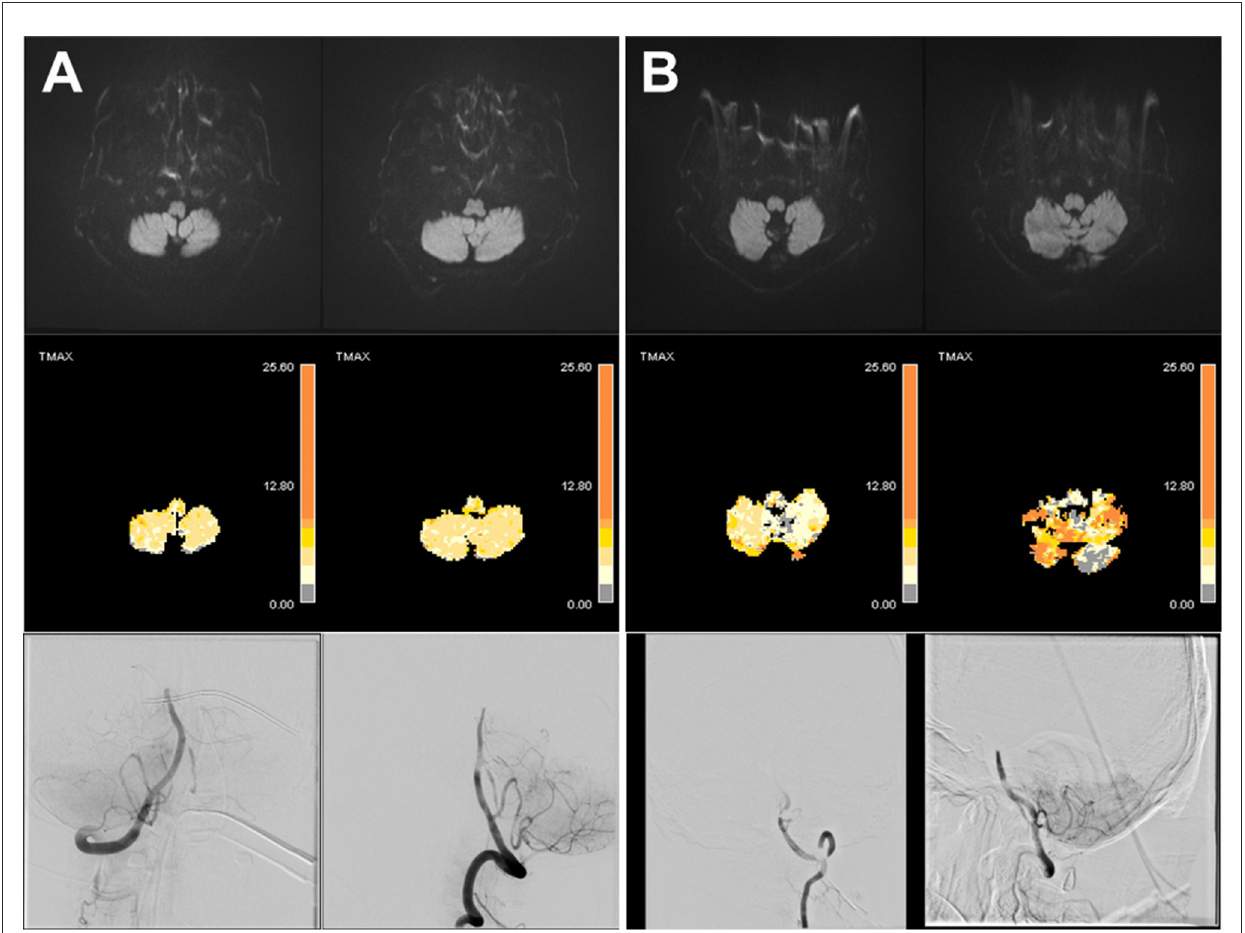
FIGURE1 Representative cases of top-of-basilar occlusion with or without perfusion delay in the low cerebellum. There were two cases of top-of-basilar artery occlusion without diffusion-restriction lesions. There was no perfusion delay in the low cerebellum (A) ; however, there was a prominent perfusion delay in the low cerebellum (B)